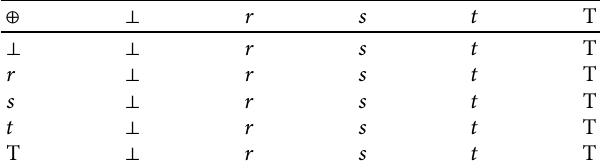
Table 4: Binary operation subject to ⊕